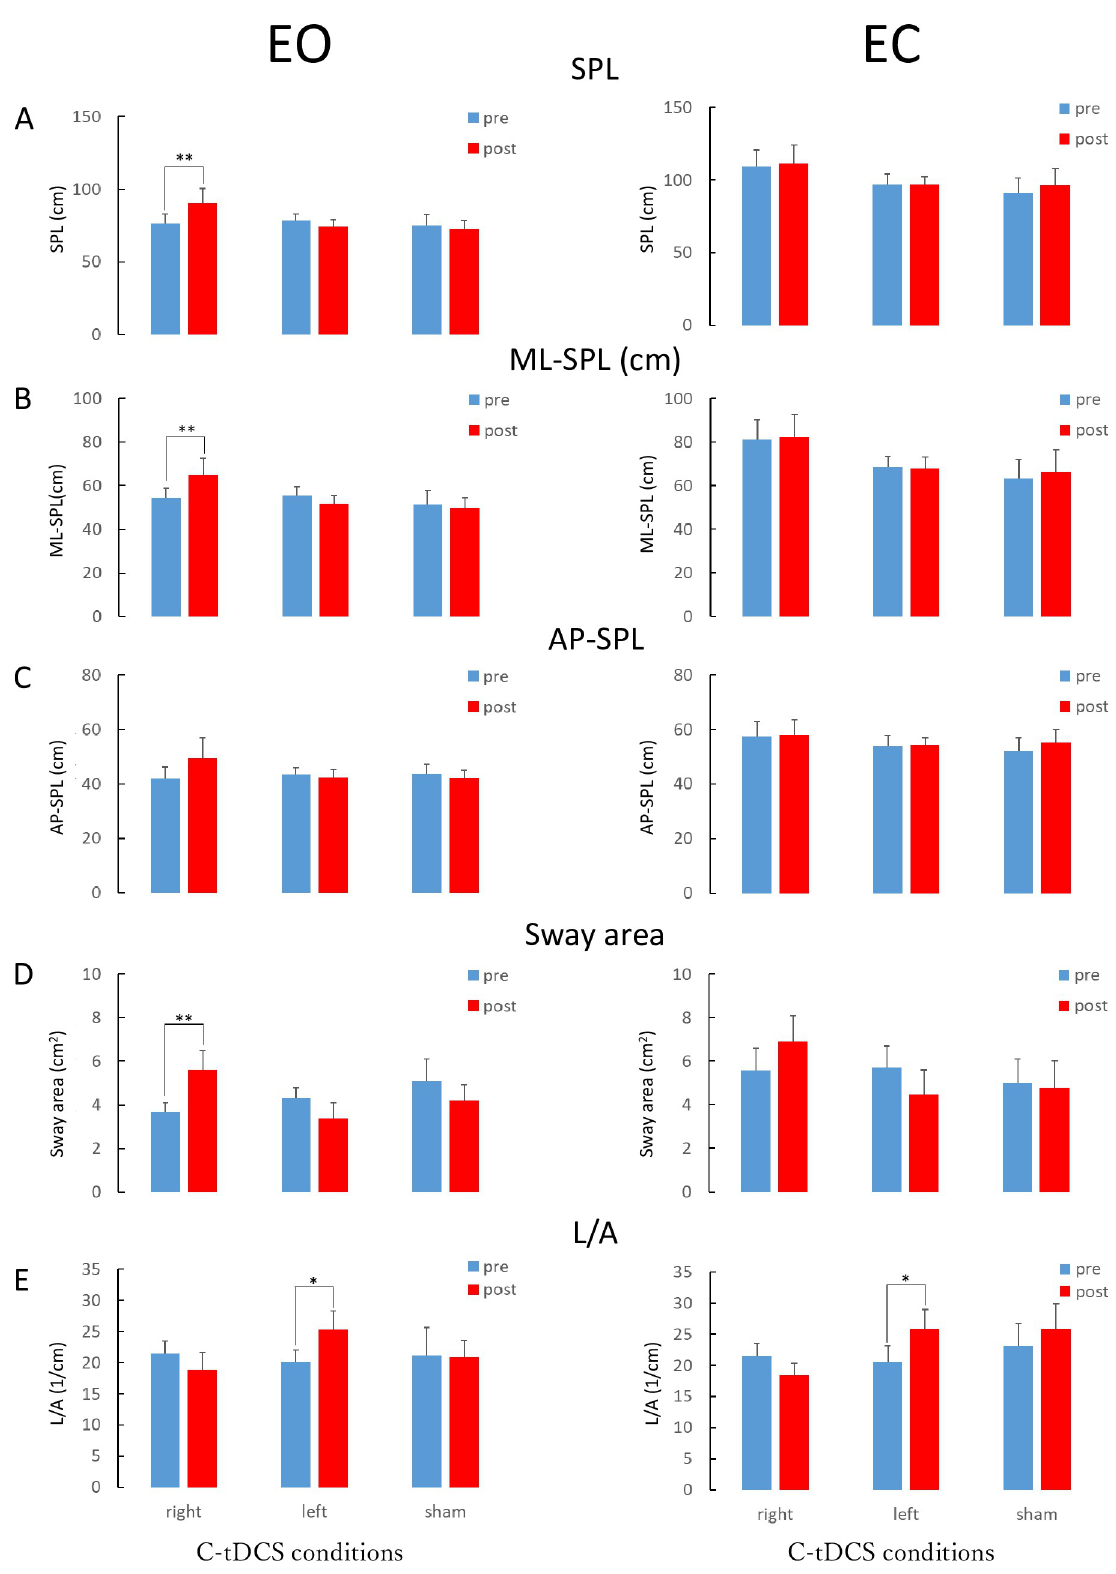
Fig 2. Effect of C-tDCS in SPL, ML-SPL, AP-SPL, sway area, and L/A. Right side: EO conditon, Left side: EC condition, A: SPL, B: ML-SPL, C: AP-SPL, D: Sway area, E: L/A, Blue bar: pre, Red bar: post, paired t-test, �� p < 0.01, � p < 0.05, SPL: Sway path length. https://doi.org/10.1371/journal.pone.0269145.g002 PLOS ONE | https://doi.org/10.1371/journal.pone.0269145 September 22,